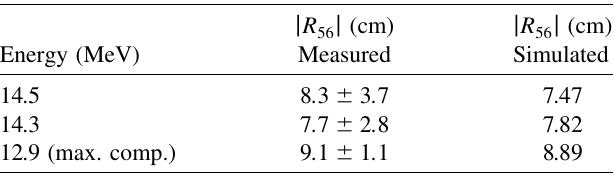
TABLE II. Measured versus simulated R . The chicane di- 56 poles current was kept constant [to 1.8 A (for the outer dipoles)], ) are a function of the energy of the bending angle (and thus R 56 the incoming two-macroparticle bunch. The case of maximum compression (referred to as max. comp.) corresponds to the nominal bending angle of 22 : 5 (cid:5)